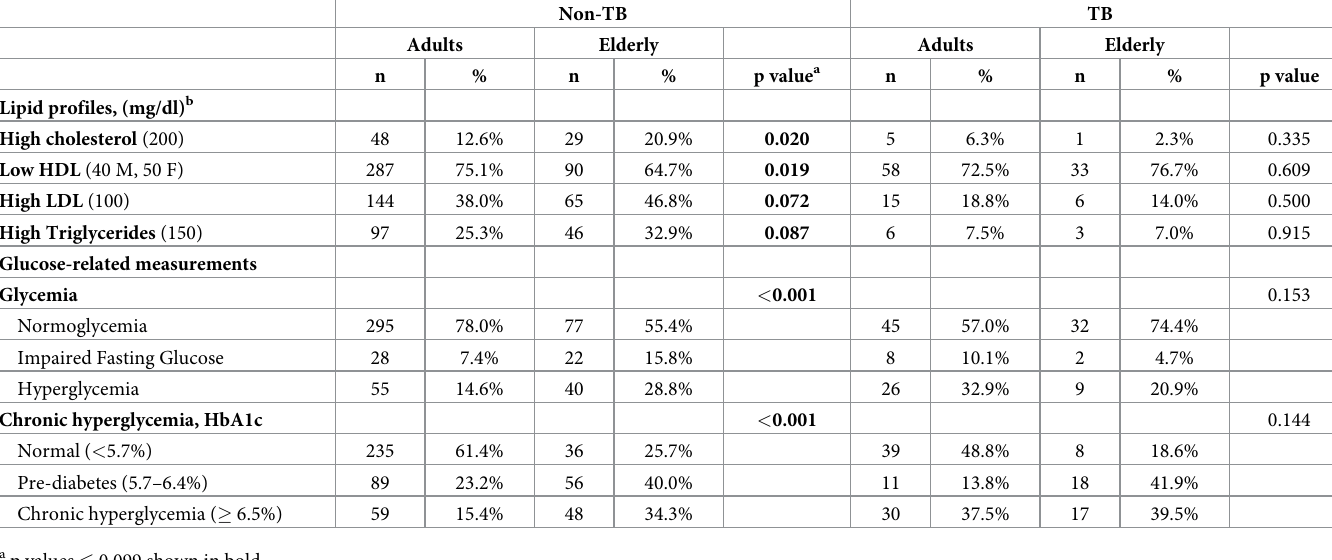
Table 2. Lipid and glucose profiles in elderly vs . adults, by TB